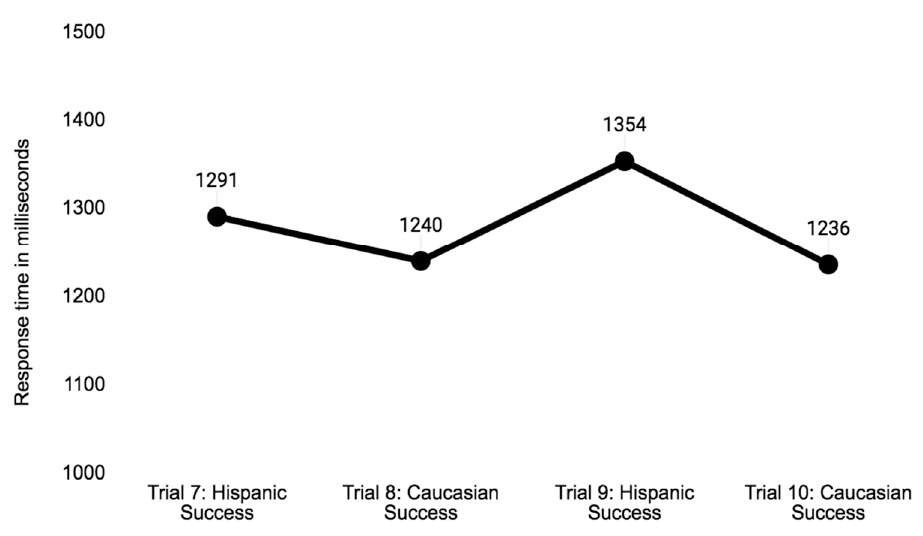
Figure 1. Average IAT response times for trials pairing Hispanic–Success/White–Failure and His- Hispanic–Failure/White–Success, in panic–Failure/White–Success, in milliseconds.